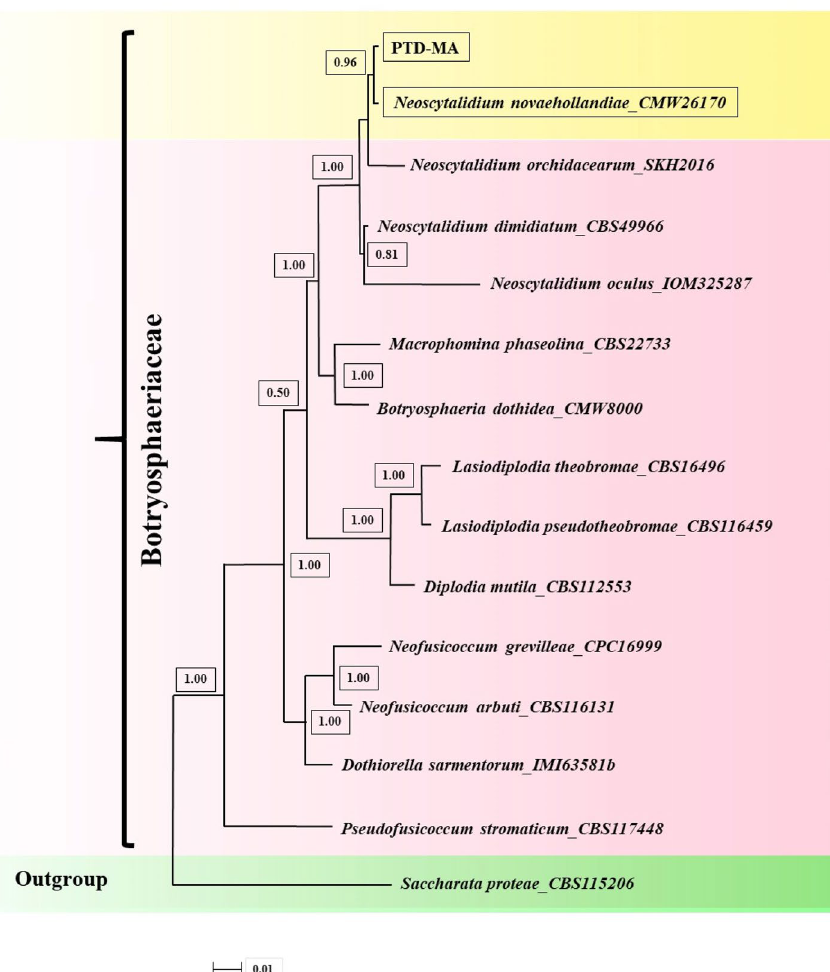
Figure 4. Bayesian tree inferred under the SYM + G model from the combined sequences of ITS and LSU for Neoscytalidium novaehollandiae and related species of closest genus, using Saccharata proteae as outgroup. The sequences aligned using MAFFT software and edited using Gblocks program. Bayesian posterior probabilities more than 0.50 are given for appropriate clades. Newly obtained sequence and another isolate of N. novaehollandiae indicated by yellow framework. PTD-MA is the strain of this